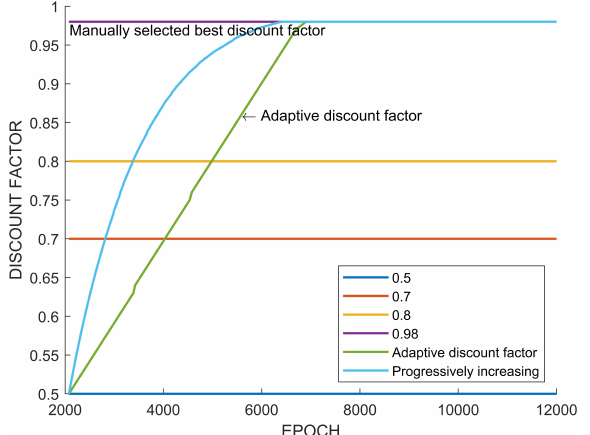
Figure 13. Adjustment of discount factor in episodic path planning